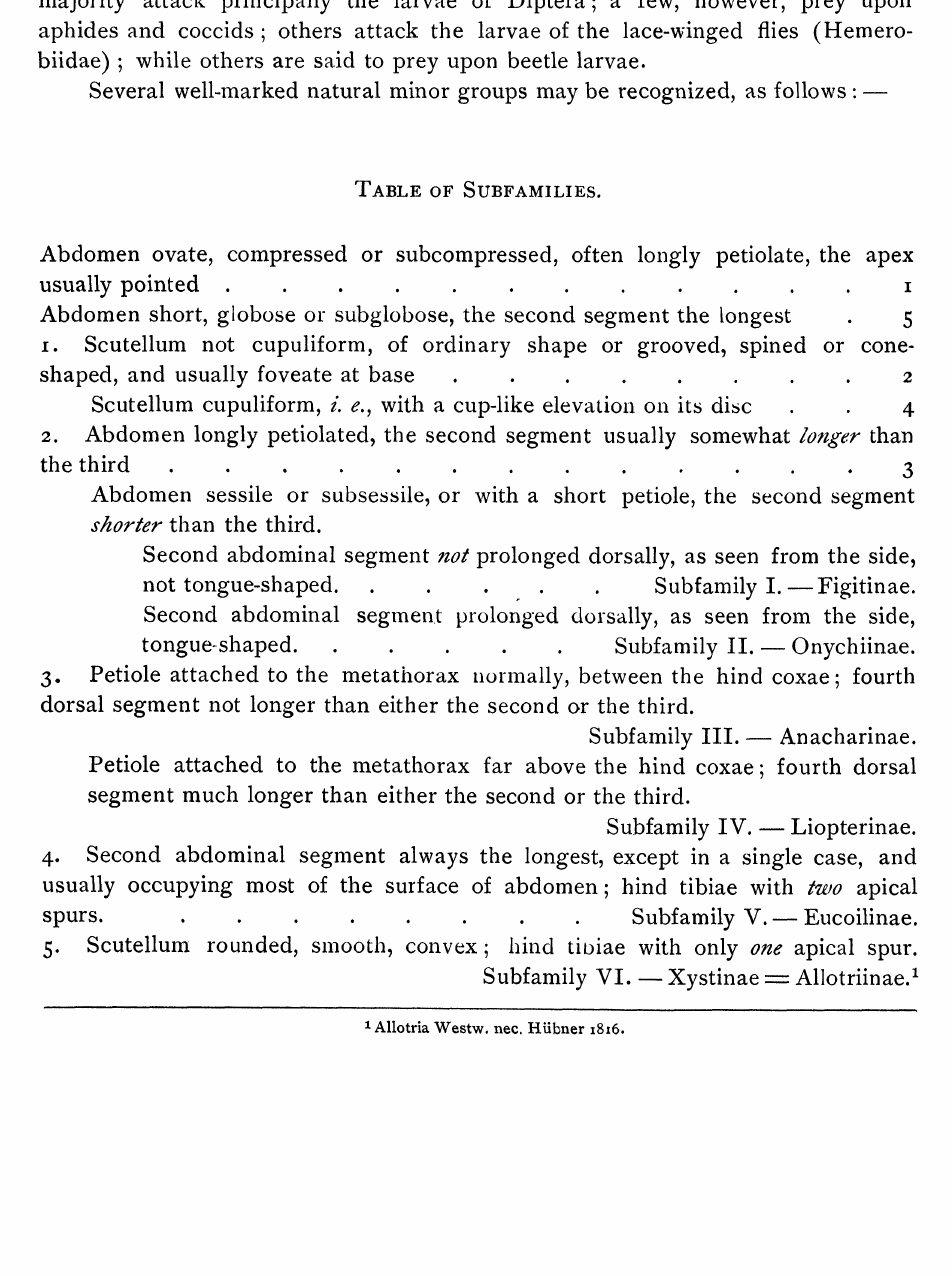
Onychiinae. Subfamily III.-